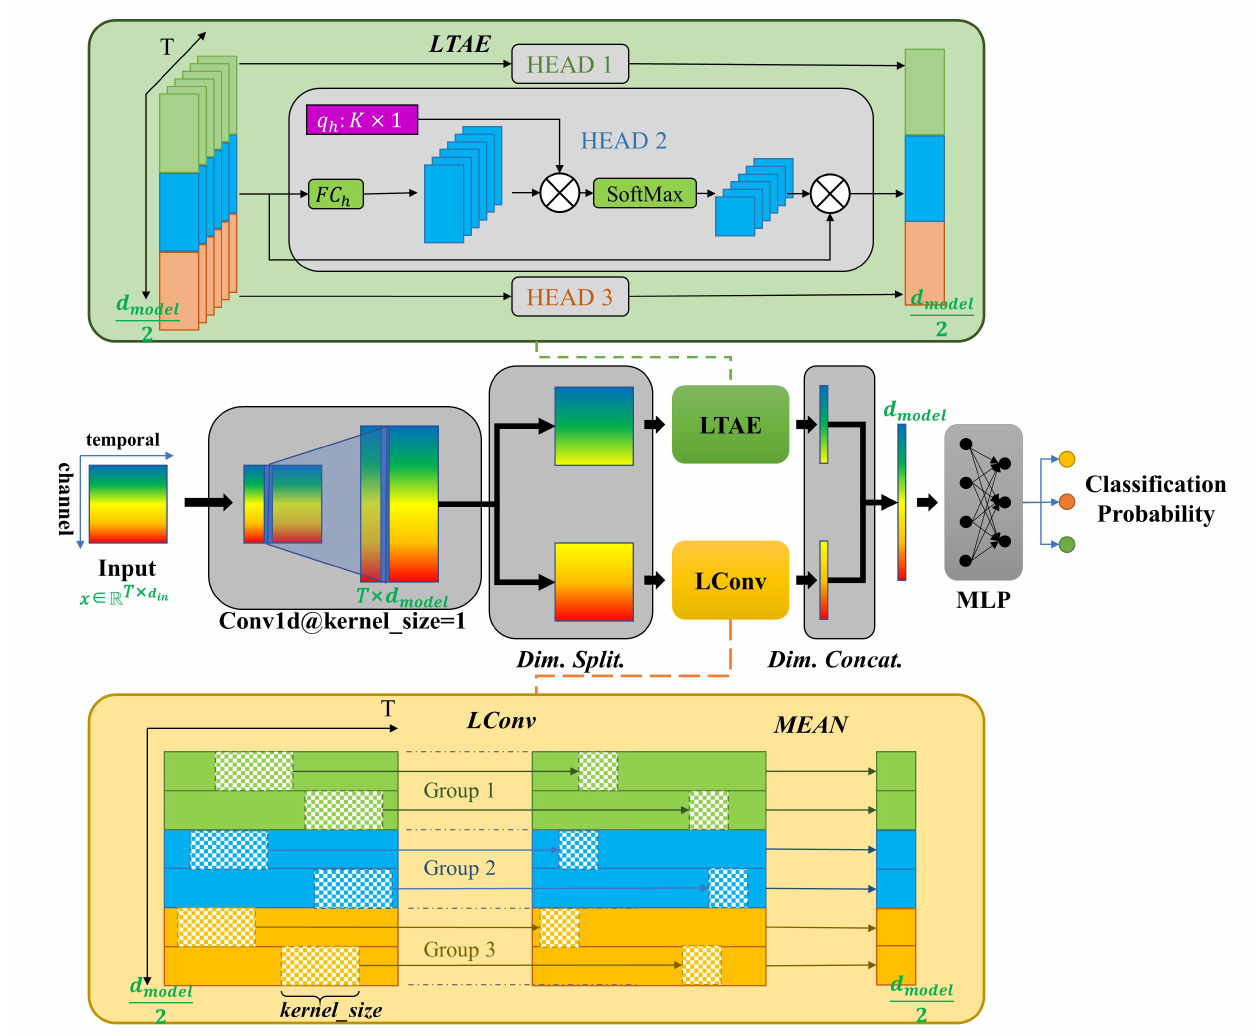
Figure 1. Overall architecture of the proposed global–local temporal attention encoder (GL-TAE). The left part depicts the whole structure of GL-TAE and the right part portrays structures of LTAE and LConv with n head = n groups =